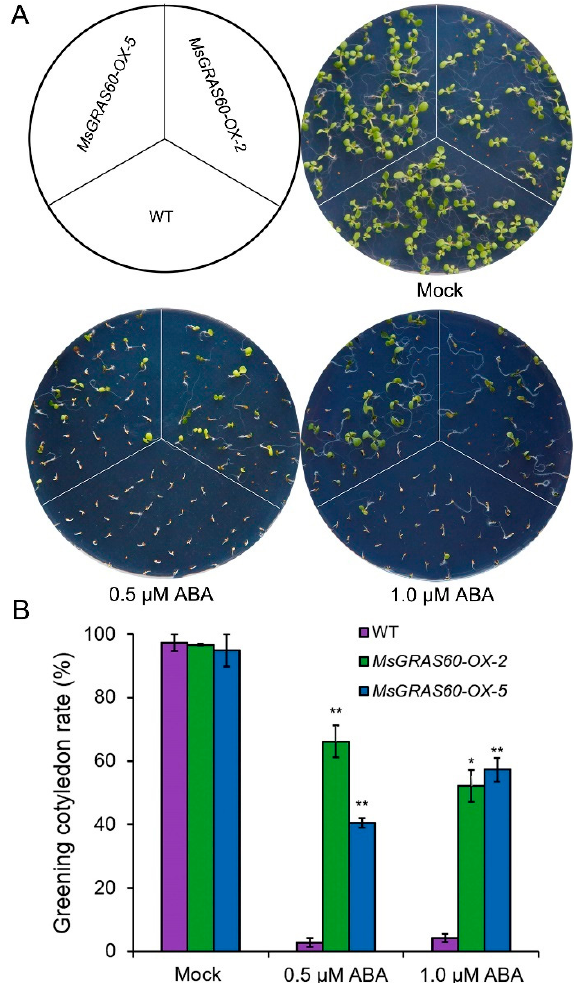
Figure 8. ABA sensitivity assay of MsGRAS60 overexpression lines. ( A ) Germination assay of WT and two MsGRAS60 overexpression lines. Seeds were sown on the 1/2 MS plate supplemented with 0, 0.5, and 1.0 μ M ABA. ( B ) Statistics of greening cotyledon rates of WT and MsGRAS60 overexpression lines on 1/2 MS plate supplemented with 0, 0.5, and 1.0 μ M ABA. Values represent mean ± SE of three biological replicates. Asterisks indicate significant differences between transgenic plants and WT based on Student’s t -test (* p < 0.05; ** p < 0.01).